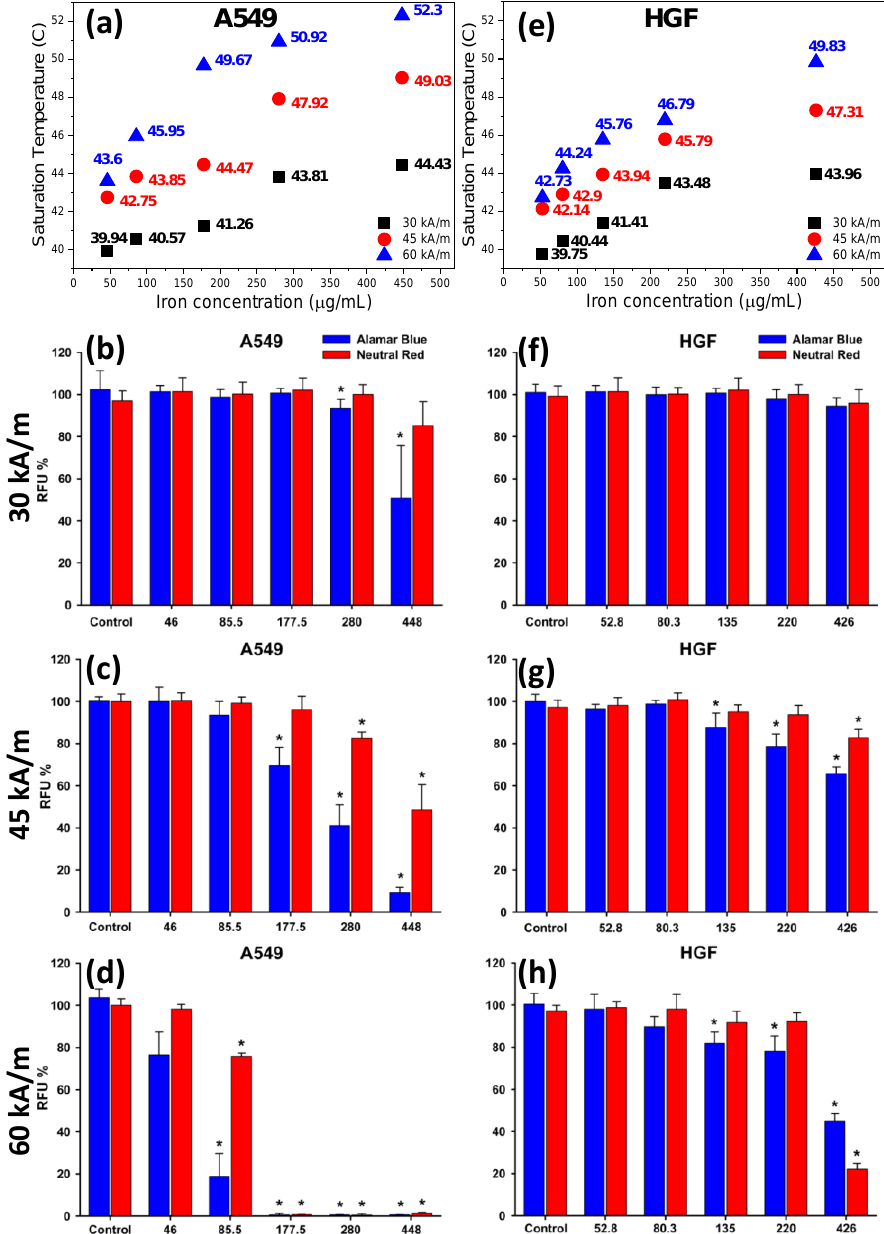
Figure 8. Saturation temperatures and cytotoxic effect of internalized IOMNPs on ( a – d ) A549 (left panels) and ( e – h ) HGF (right panels) evaluated after a 30 min exposure to three different values of H (30, 45, and 60 kA/m). Cellular viability was measured using Alamar Blue and Neutral Red assays. The values are expressed as mean ± SD of three biological replicates. Data are expressed as relative values to the negative control. Asterisks (*) indicate significant differences compared to the negative control (ANOVA + Dunn’s; P < 0.05).